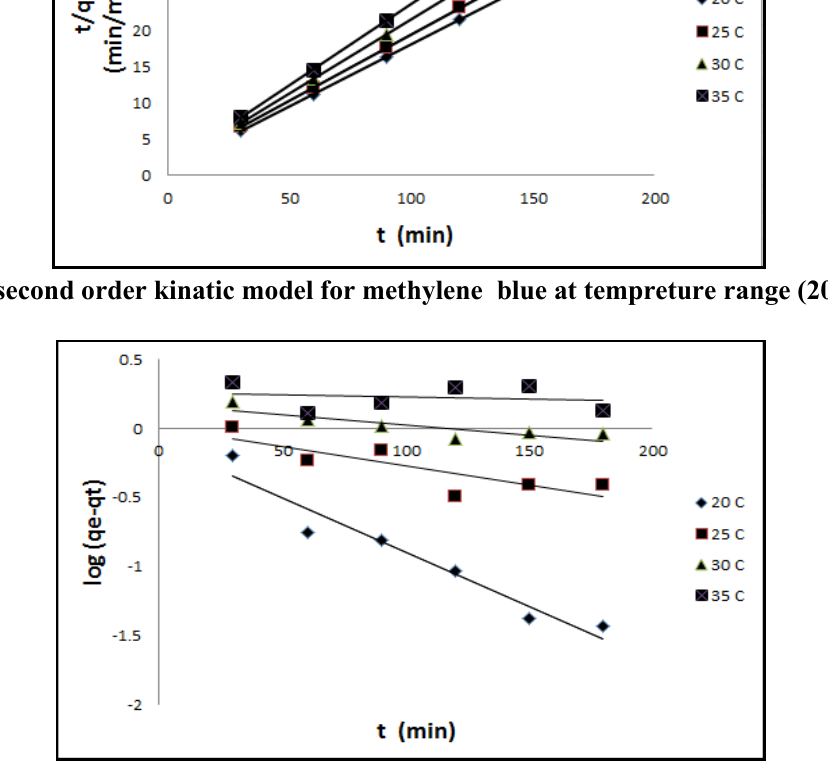
Fig. 11. first order kinatic model for methyl orange at tempreture range (20−35) °C.